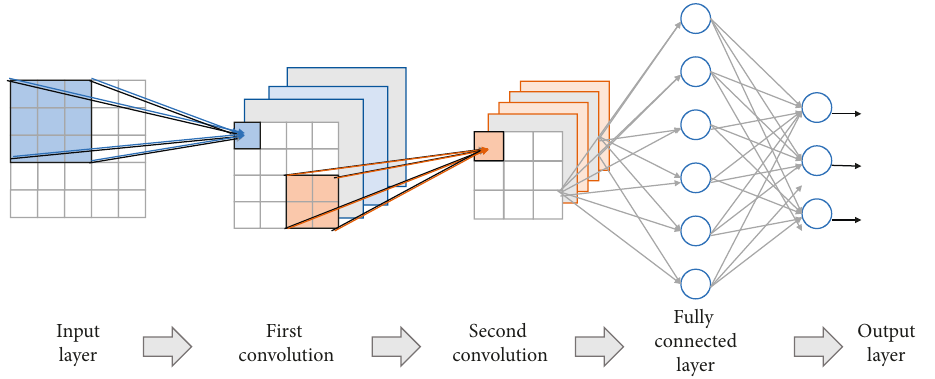
Figure 3: CNN architecture illustration.